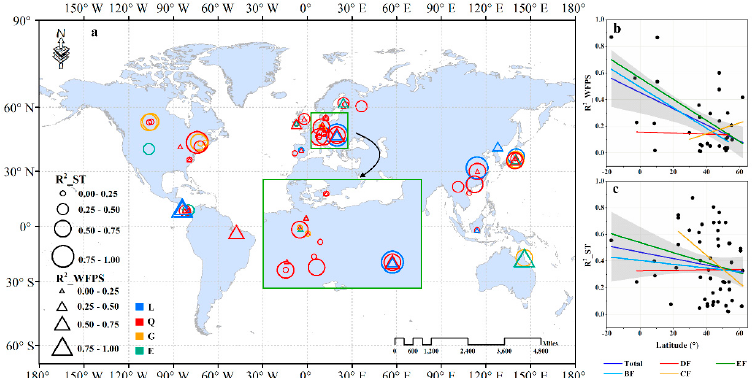
Figure 7. ( a ) Biogeographic patterns of the coefficient of determination ( R 2 ) of linear regression (L), quadratic regression (Q), logarithmic regression (G) or exponential regression (E) between N 2 O fluxes and soil temperature and WFPS ( R 2 _ST and R 2 _WFPS, respectively); ( b ) the relationship between